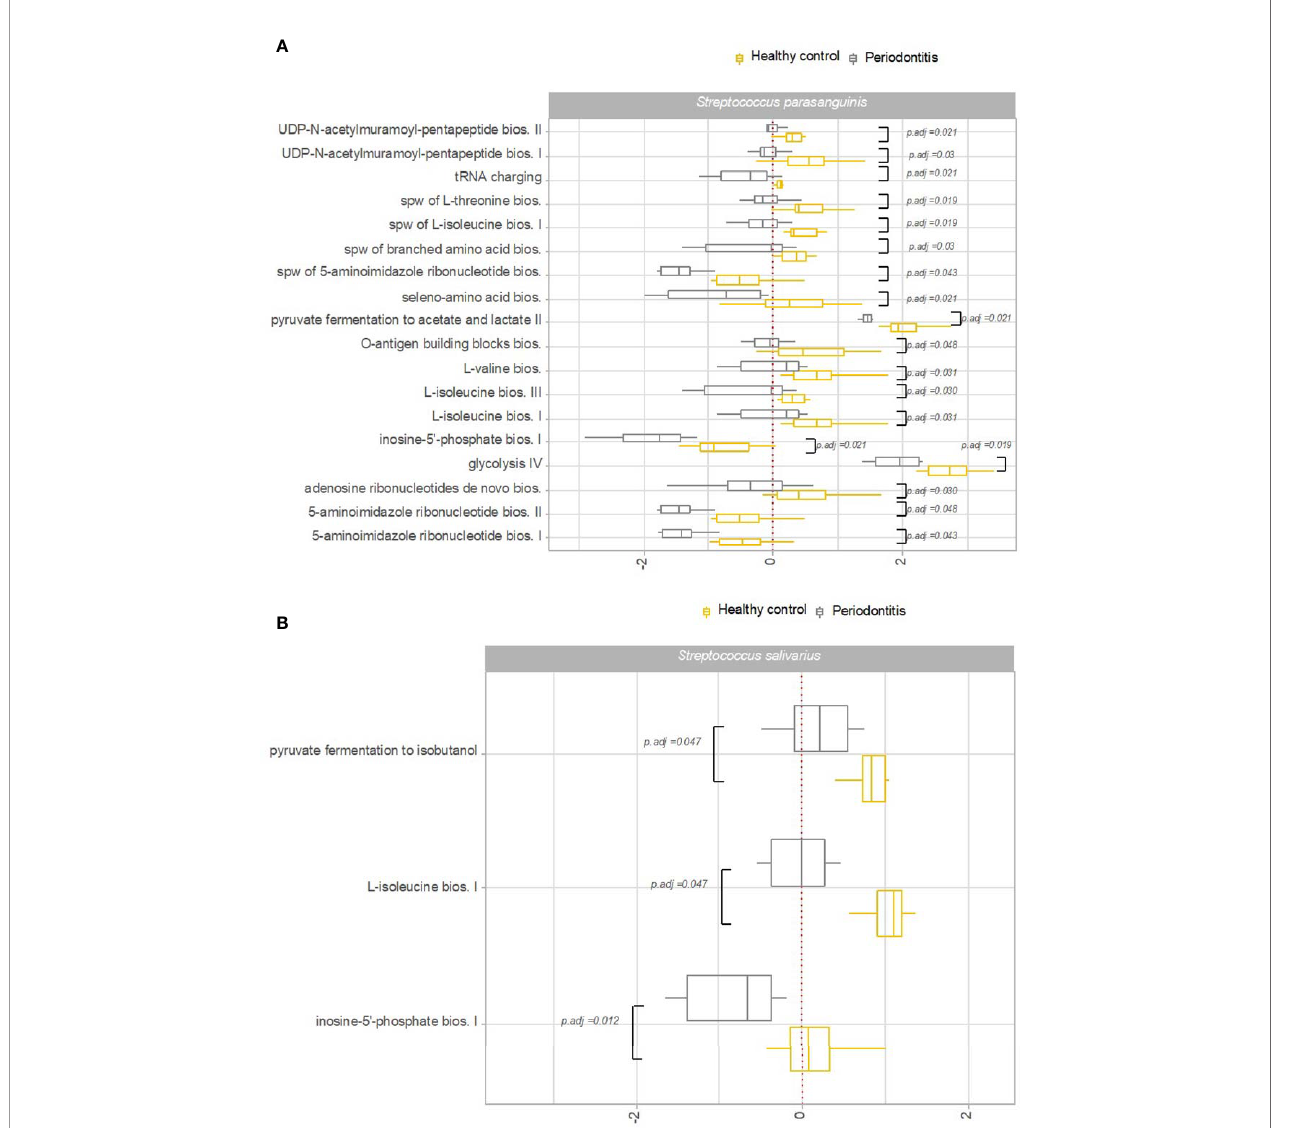
FIGURE 6 | Pathway expression of Streptococcus species in saliva in periodontitis versus oral health. Pathways identi fi ed with signi fi cantly different log2(RNA/DNA) in saliva from patients with periodontitis versus oral health, with each dot representing a speci fi c sample. (A) Streptococcus parasanguinis , (B) Streptococcus salivarius . Boxplots display fi rst and third quartiles, median. Whiskers display 1.5 * IQR. Color coding: yellow: healthy control, grey: